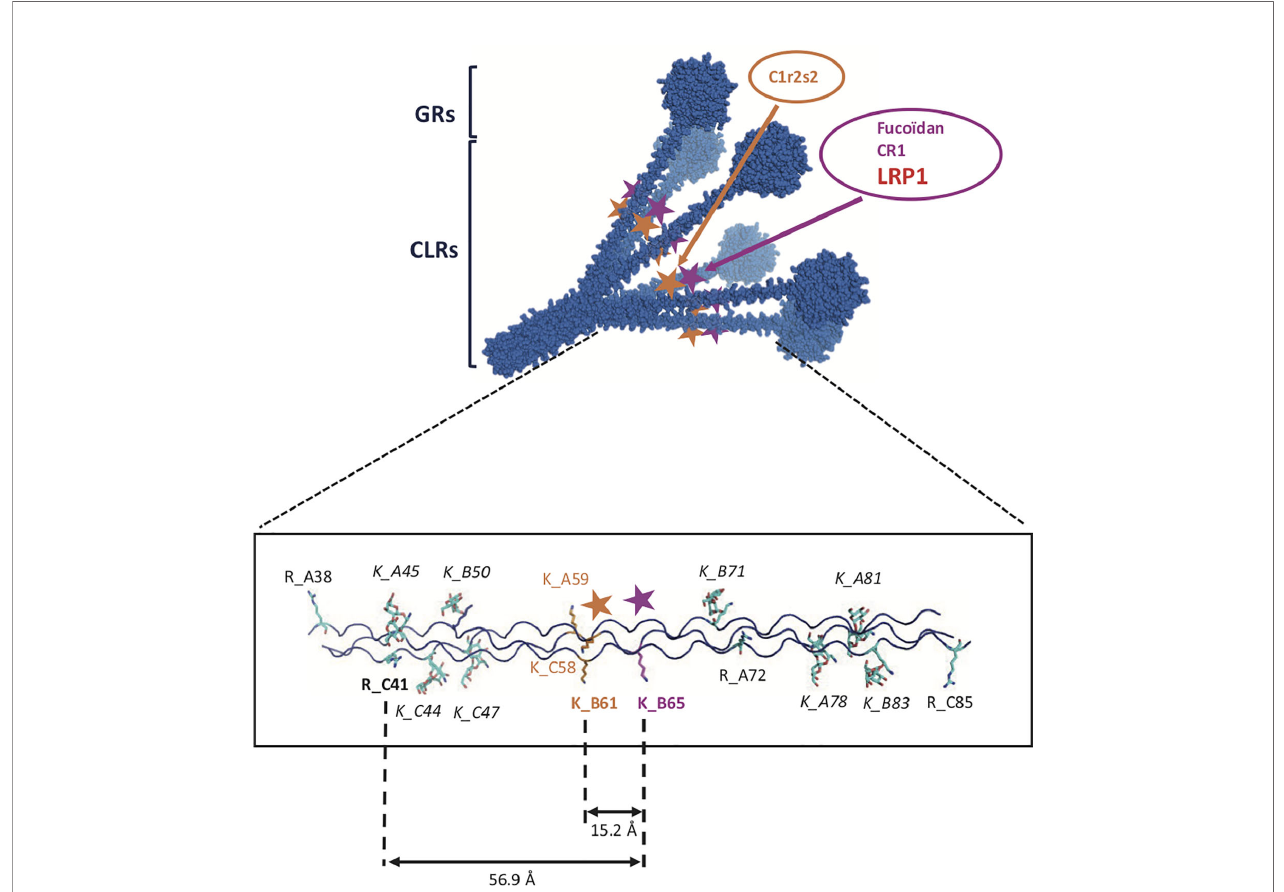
FIGURE 11 | Detailed model of C1q CLRs interaction sites. Upper part: 3-D model of C1q representing a bouquet-like scaffold formed by 6 collagen stalks (CLRs) expending into 6 globular regions (GRs). The two interaction sites for C1r2s2 and for CLR ligands such as LRP1, fucoidan and CR1 are indicated by orange and pink stars, respectively. Bottom part: detailed localization of basic amino acids on one C1q CLR. Lysines or arginines are labeled by R or K letters, followed by the name of the C1q chain, A, B or C and amino acid position. Italics are indicating glycosylated lysines. Bold characters represent residues potentially involved in the binding of